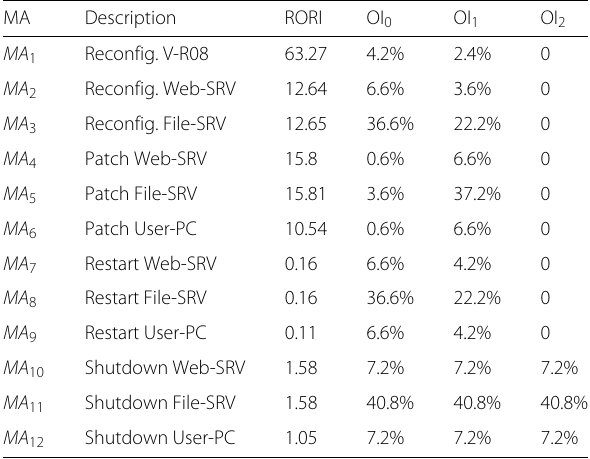
Table 4 Examples of ROIA evaluations for proposed response plans RP i consisting of a single mitigation action MA i for threat scenario AS 02 corresponding to Table 3. ( RORI given for reference